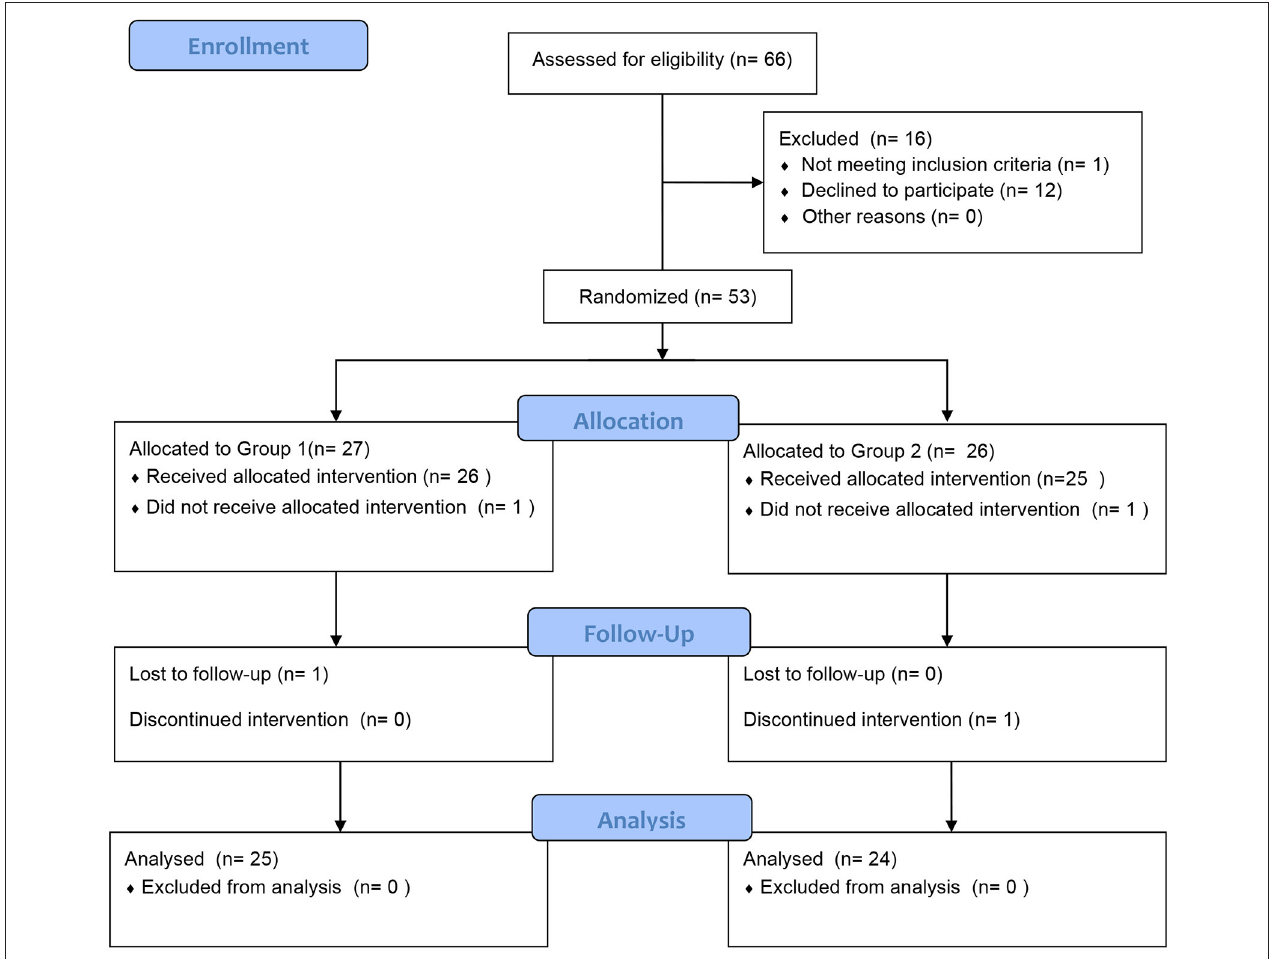
FIGURE 2 | Patient diagram. In total, 66 subjects were recruited and randomly assigned to the two treatment groups to receive either acaricidal bait or placebo. Fifty children qualified and completed the first phase of the trial, and 49 children completed the entire trial.